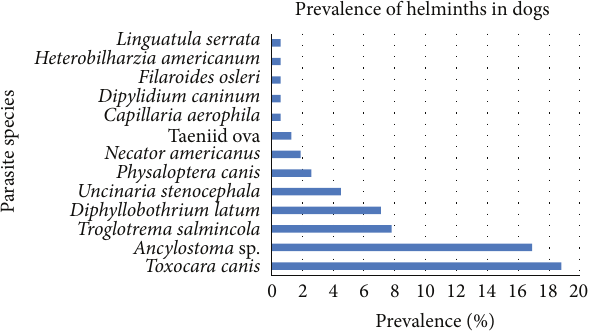
Figure 1: Distribution of helminths found in dog excrement ( 𝑛 = 154